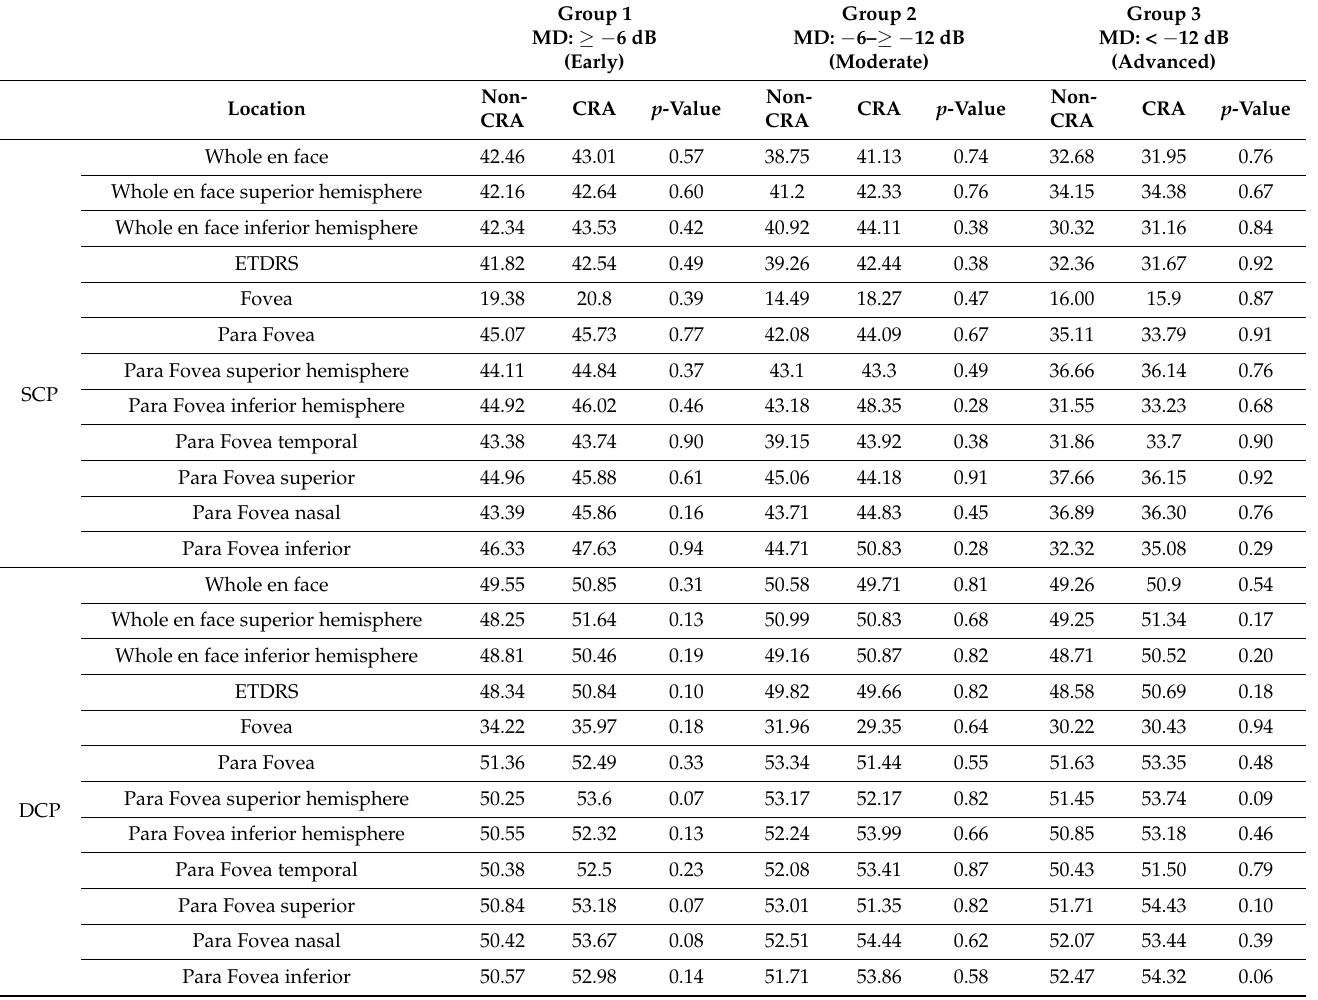
Table 4. Difference in FD between the CRA and non-CRA patients, adjusted for glaucoma